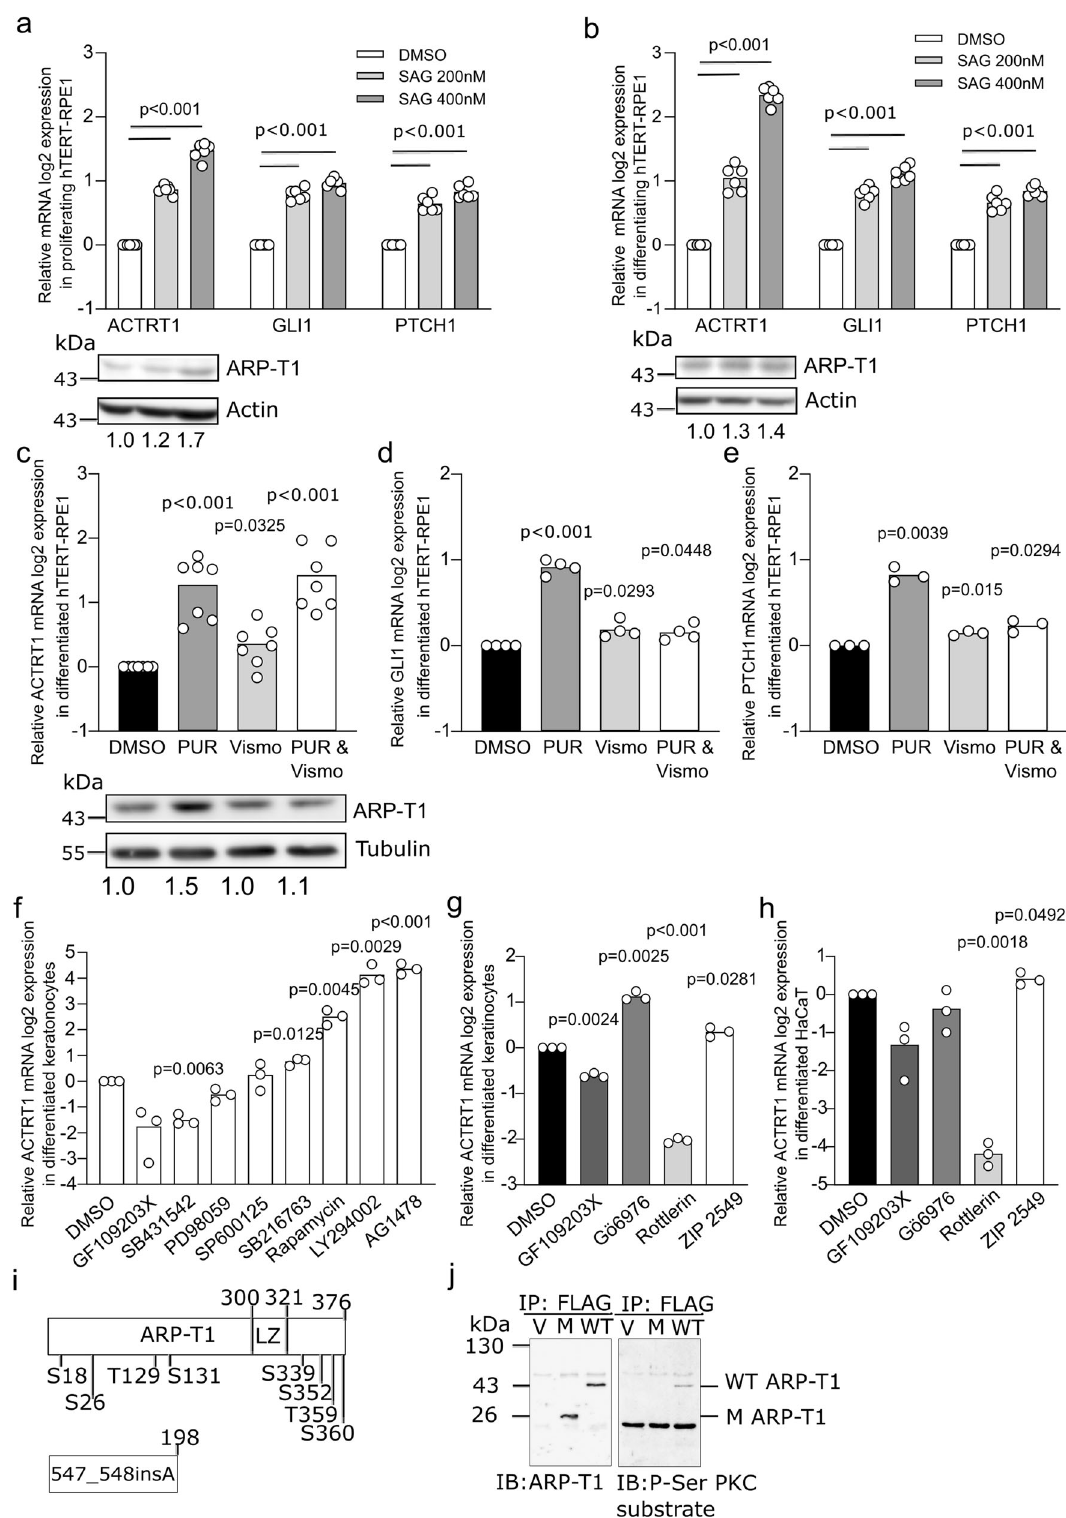
Fig. 1h). In the same cells, we con fi rmed that ARP-T1 co-localizes with EHD4 (Supplementary Fig.